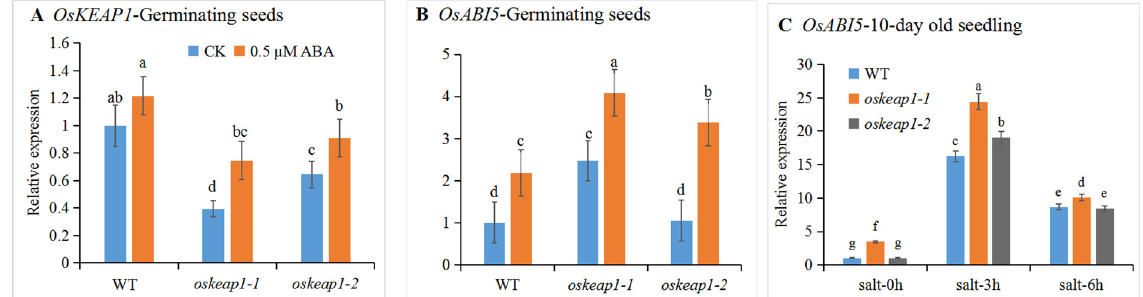
Figure 3. Relative expression of OsKEAP1 and OsABI5 in germinating seeds and seedlings. ( A , B ) Germinating seeds 4 days after germinating on a 0.5 MS medium without abscisic acid (ABA) (CK) or with 0.5 µM ABA. ( C ) Ten-day-old seedlings subject to 200 mM NaCl for 3 h (salt-3 h) or 6 h (salt-6 h) or without NaCl treatment (salt-0 h). The expression levels of the same gene in different materials or grown under different conditions were compared with the wild-type (WT) grown without the treatment (its level was set as 1). OsACTIN was used as an internal reference. Data are shown in mean ± standard error of three biological repeats. One-way ANOVA was performed for the statistical analysis, where different letters represent significant differences ( p ≤ 0.05).